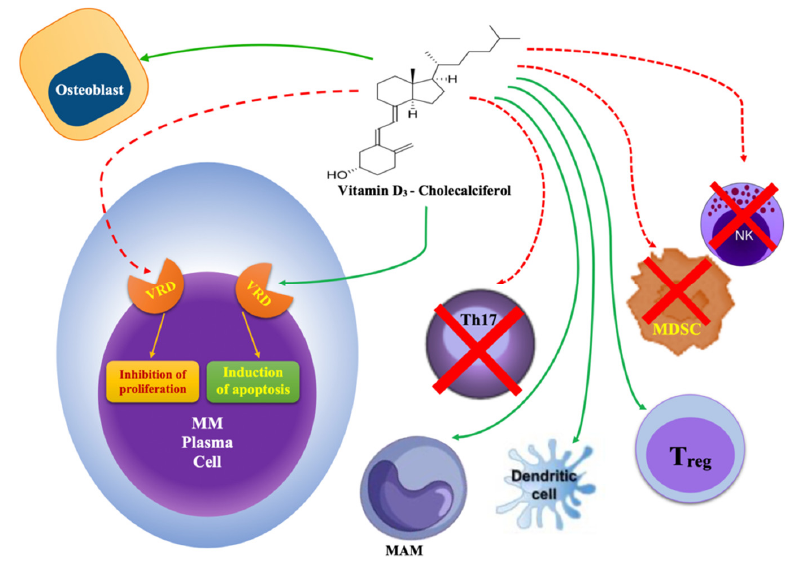
Figure 1. Vitamin D actions on the cell compartment of the bone marrow microenvironment. Green arrows indicate the stimulating effects on expansion and function, while the red dashed arrows indicate the inhibition of proliferation and cell functions [35–54].